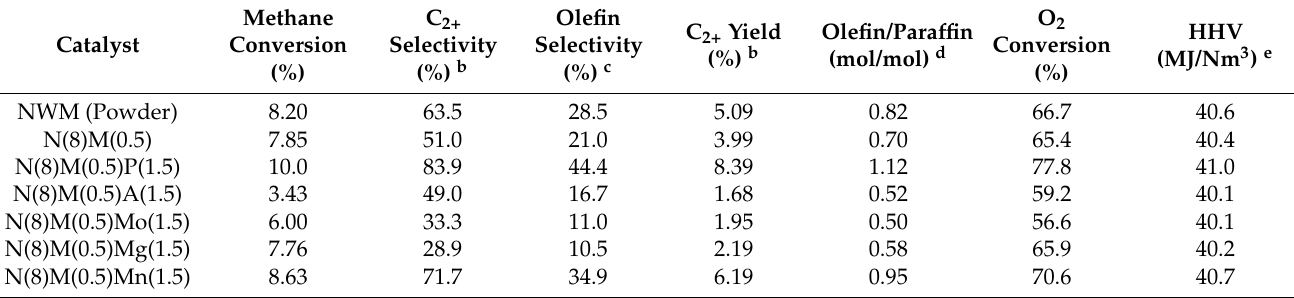
Table 3. OCM results of simulated biogas at 800 ◦ C using catalyst pellets with different inorganic binders a .